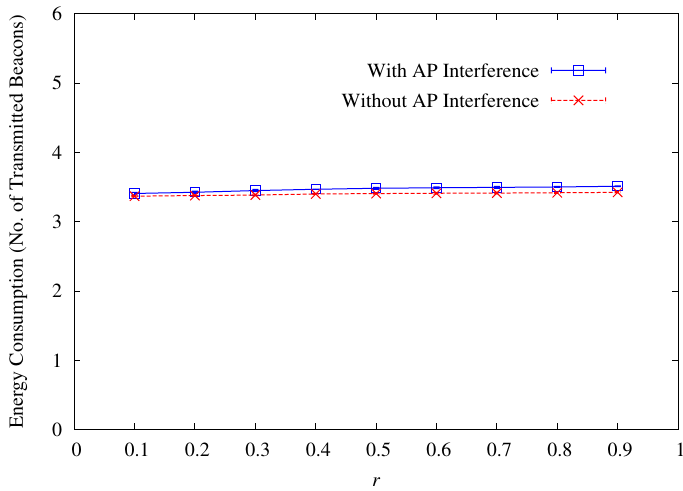
Figure 13. Impact of Wi-Fi access point (AP) interference on energy consumption.